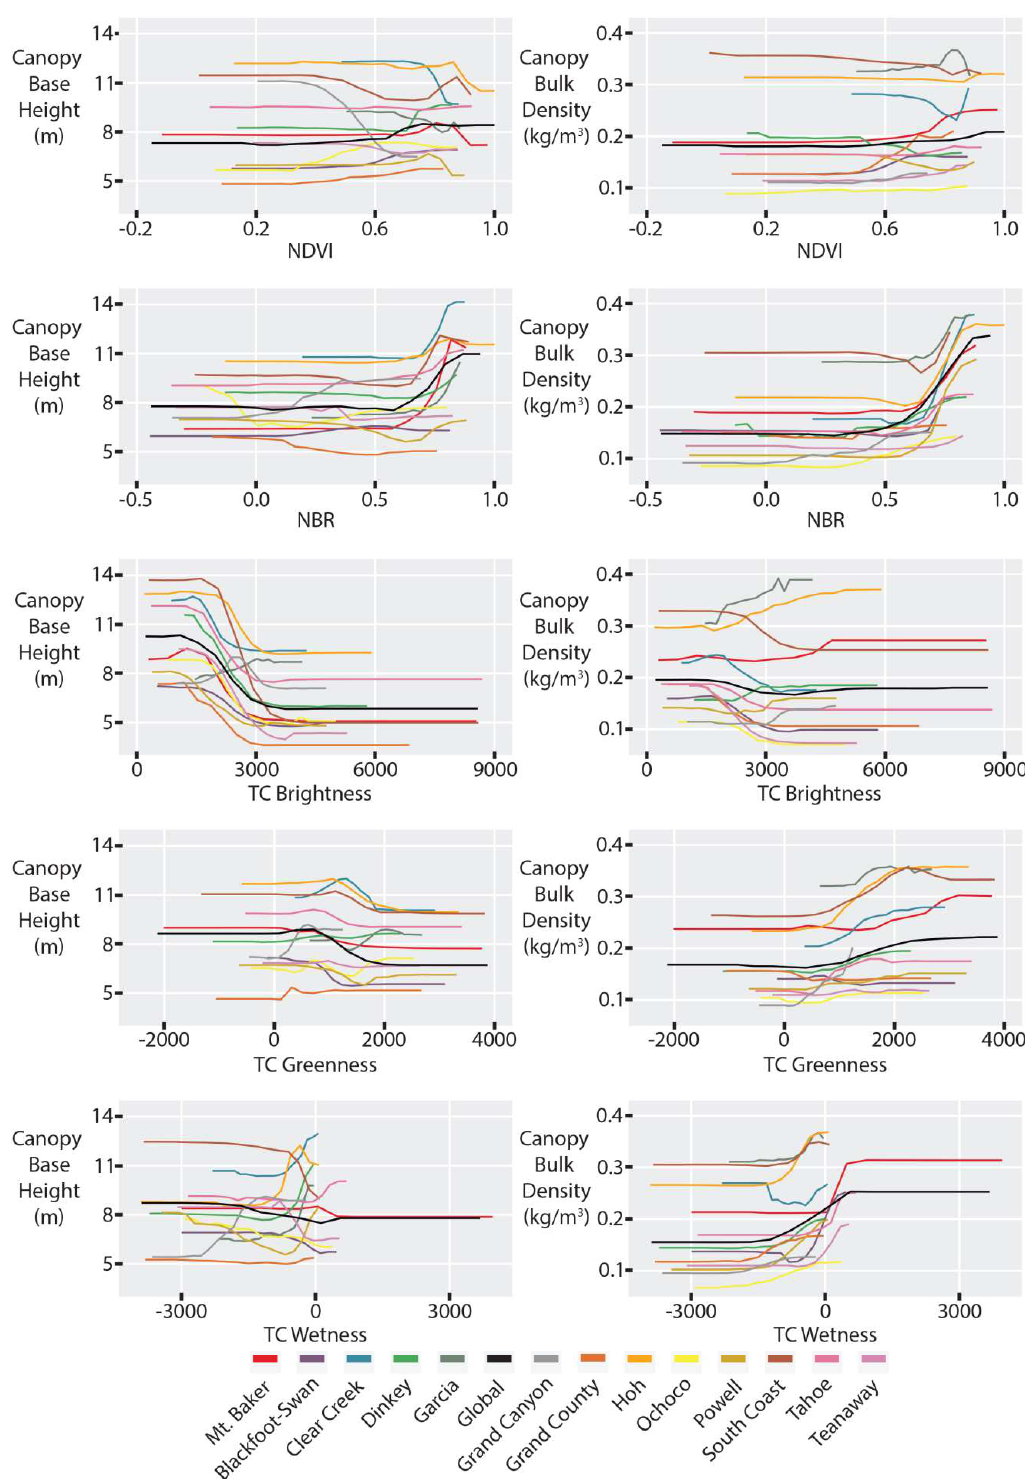
Figure 4. Partial dependence plots for each predictor variable ( x-axes ) and the canopy base height and canopy bulk density response variables ( y-axes ). Each line shows the partial dependence using the local ( colored ) and global ( black ) landscape datasets.